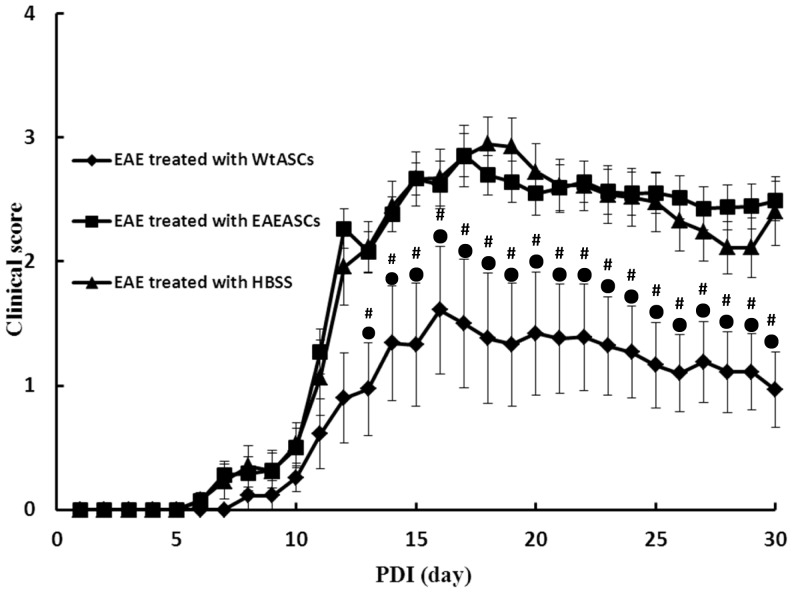
Clinical scoring for disease onset and progression.The clinical scores for the HBSS-treated (n = 20), EAEASC-treated (n = 20) and WtASC-treated (n = 20) EAE mouse groups were recorded daily for the duration of the study. WtASCs significantly reduced the clinical symptoms from PDI13 where the EAEASCs failed to mediate any therapeutic efficacy or improvement. # means P<0.01 vs HBSS-treated EAE group (post-hoc, n = 20); • means P<0.01 vs EAEASCs-treated EAE group (post-hoc, n = 20).